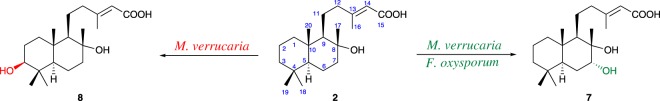
Derivatives produced by biotransformation of diterpenoid 2 with F. oxysporum and M. verrucaria.